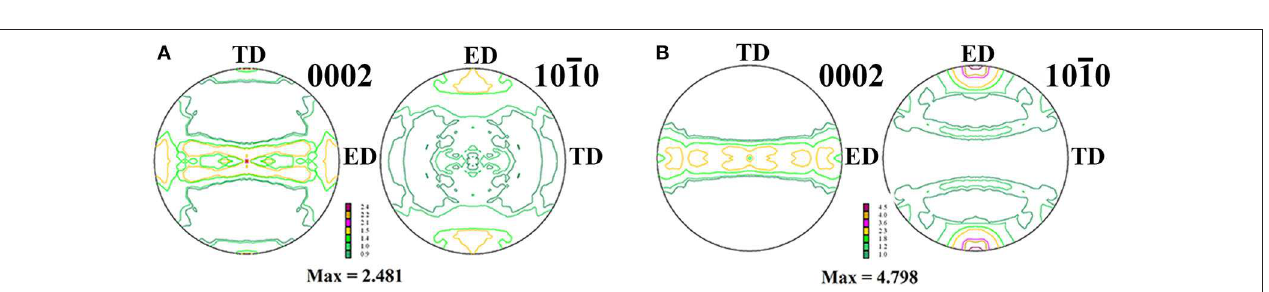
FIGURE 3 | Pole figures of (A) as-extruded Mg − 1Sn alloys and (B) as-extruded Mg − 1Sn − 0.1Ti alloys. The maximum values of texture intensities are ∼ 2.48 and ∼ 4.80,